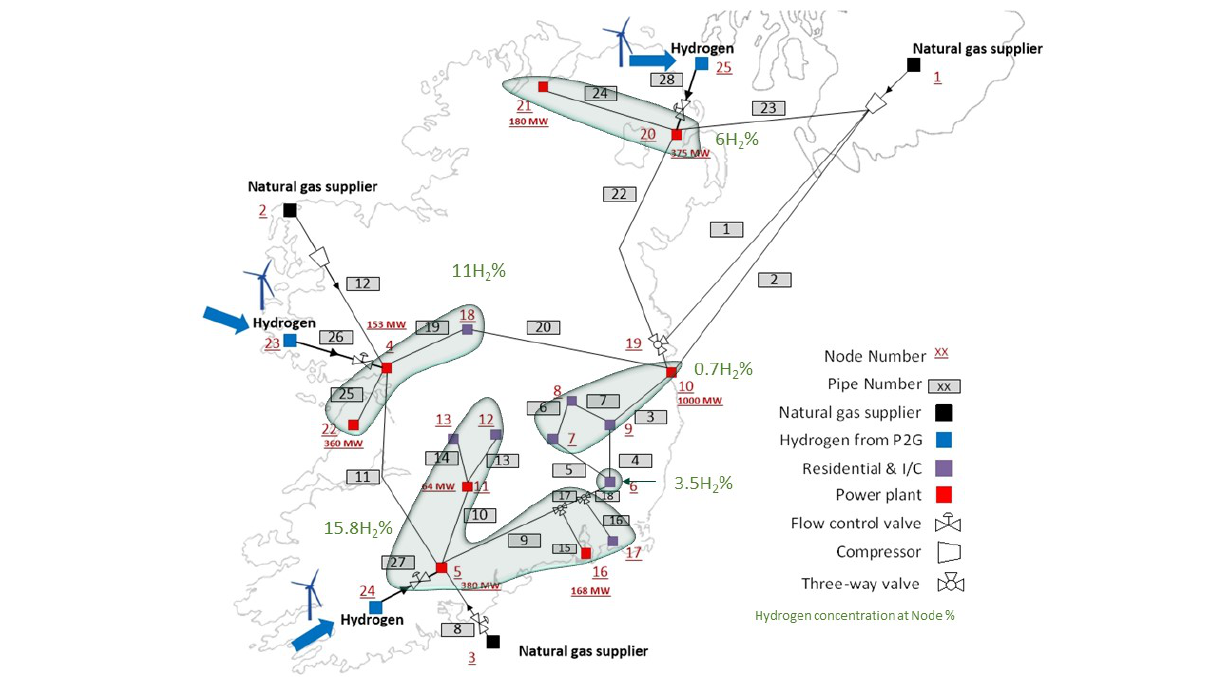
Figure 7. Hydrogen distribution in Irish gas network pipelines, Nodes with the same hydrogen concentration are surrounded by